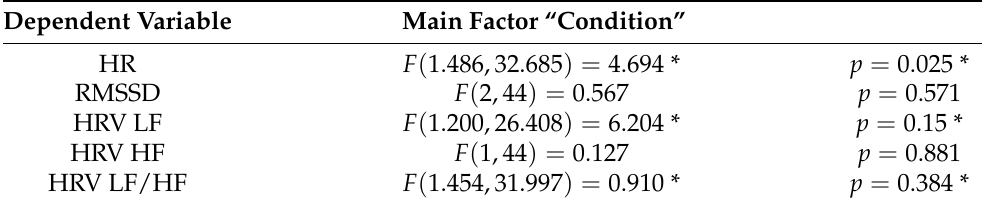
Table 4. Results of 2 × 3 ANOVA for the factor “condition” all dependent variables.